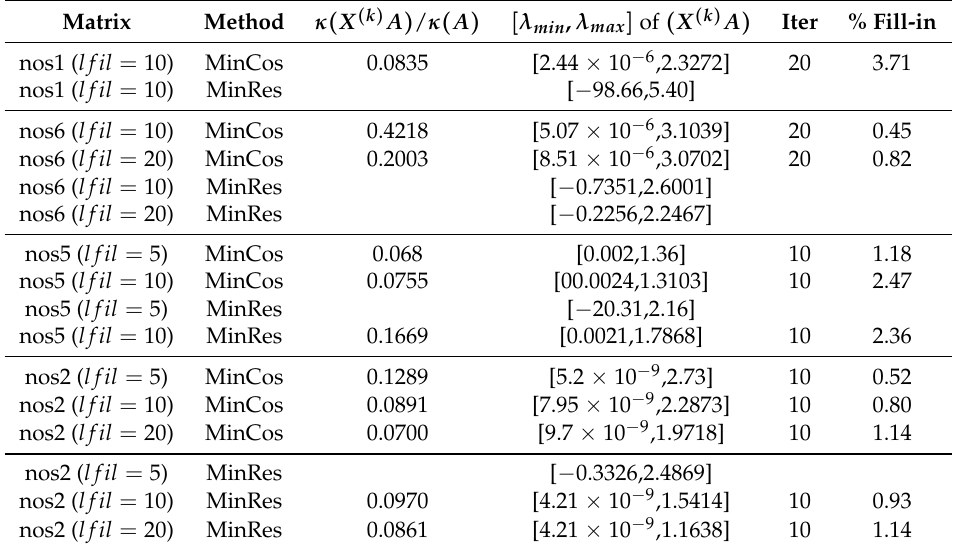
Table 3. Performance of MinRes and MinCos when applied to the Matrix Market matrices nos1, nos2, nos5, and nos6, for (cid:101) = 0.01, thr = 0.01, and different values of l fil .